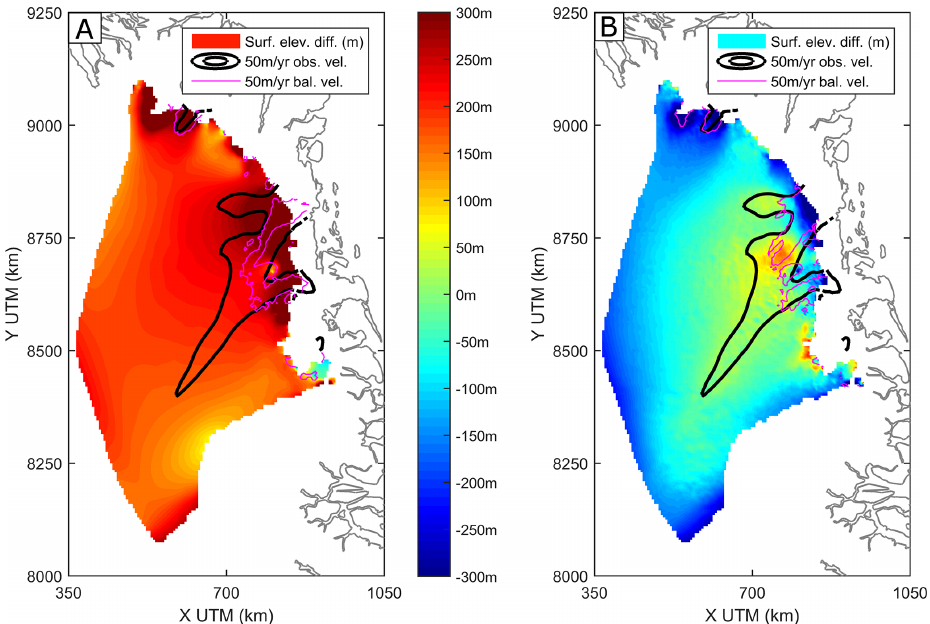
Figure 4. (a) Difference in surface elevation between the ice-sheet at the end of the spin-up run and present-day topography. (b) Difference in surface elevation between the ice-sheet at the end of the model run and present-day topography. The contour for the observed 50myr − 1 surface velocity (from Joughin et al., 2010) is indicated with thick, black lines; magenta lines indicate the 50myr − 1 balance velocity contour.